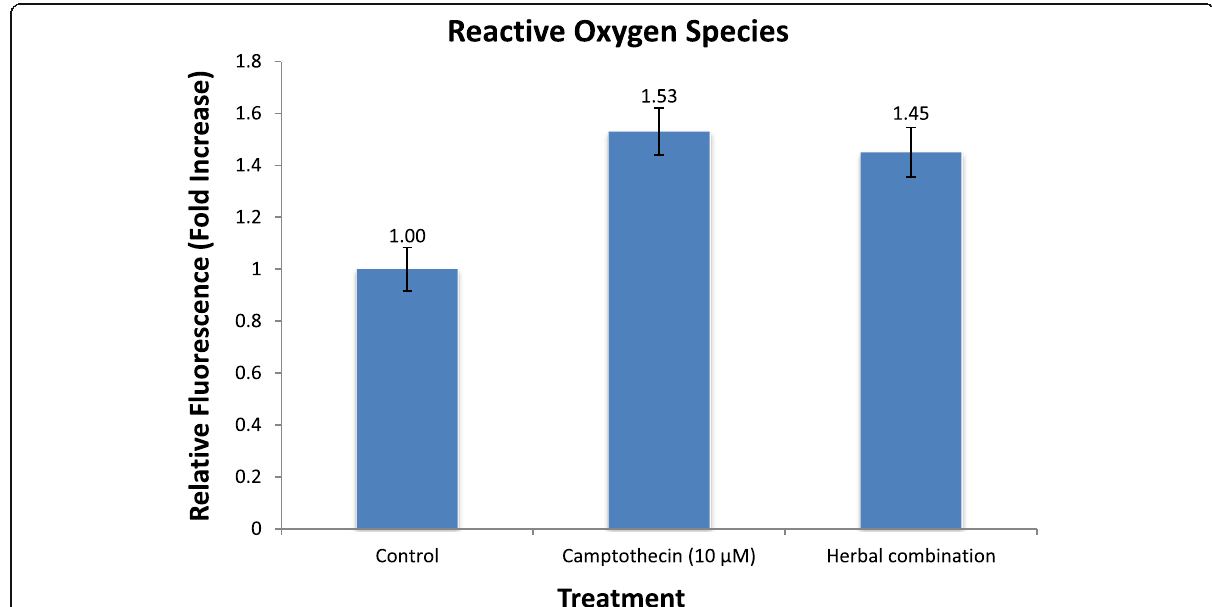
Fig. 6 Reactive oxygen species generation in HepG2 cells after treatment with IC 50 value of herbal